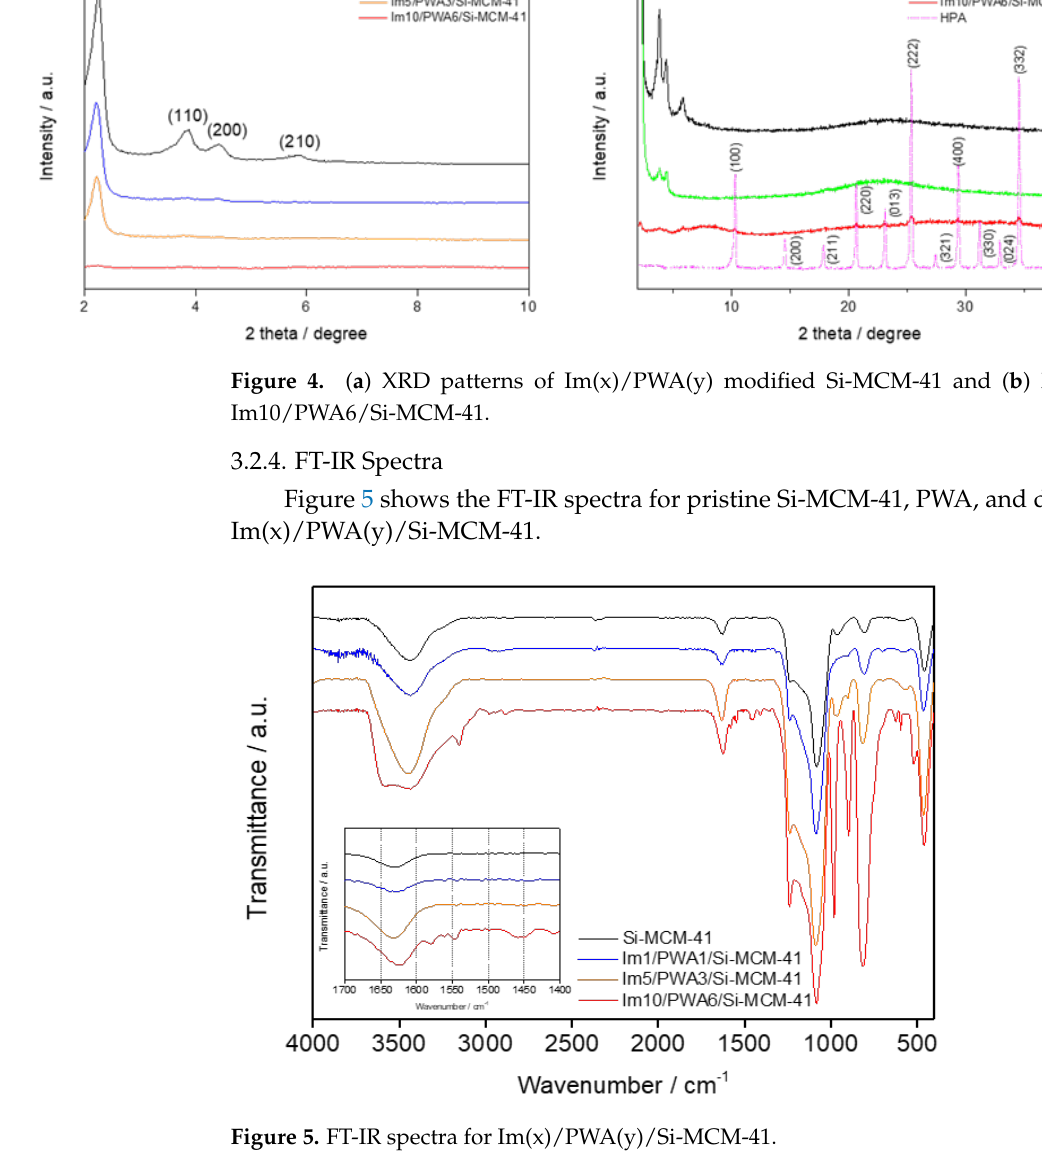
Figure 5. FT-IR spectra for Im(x)/PWA(y)/Si-MCM-41.